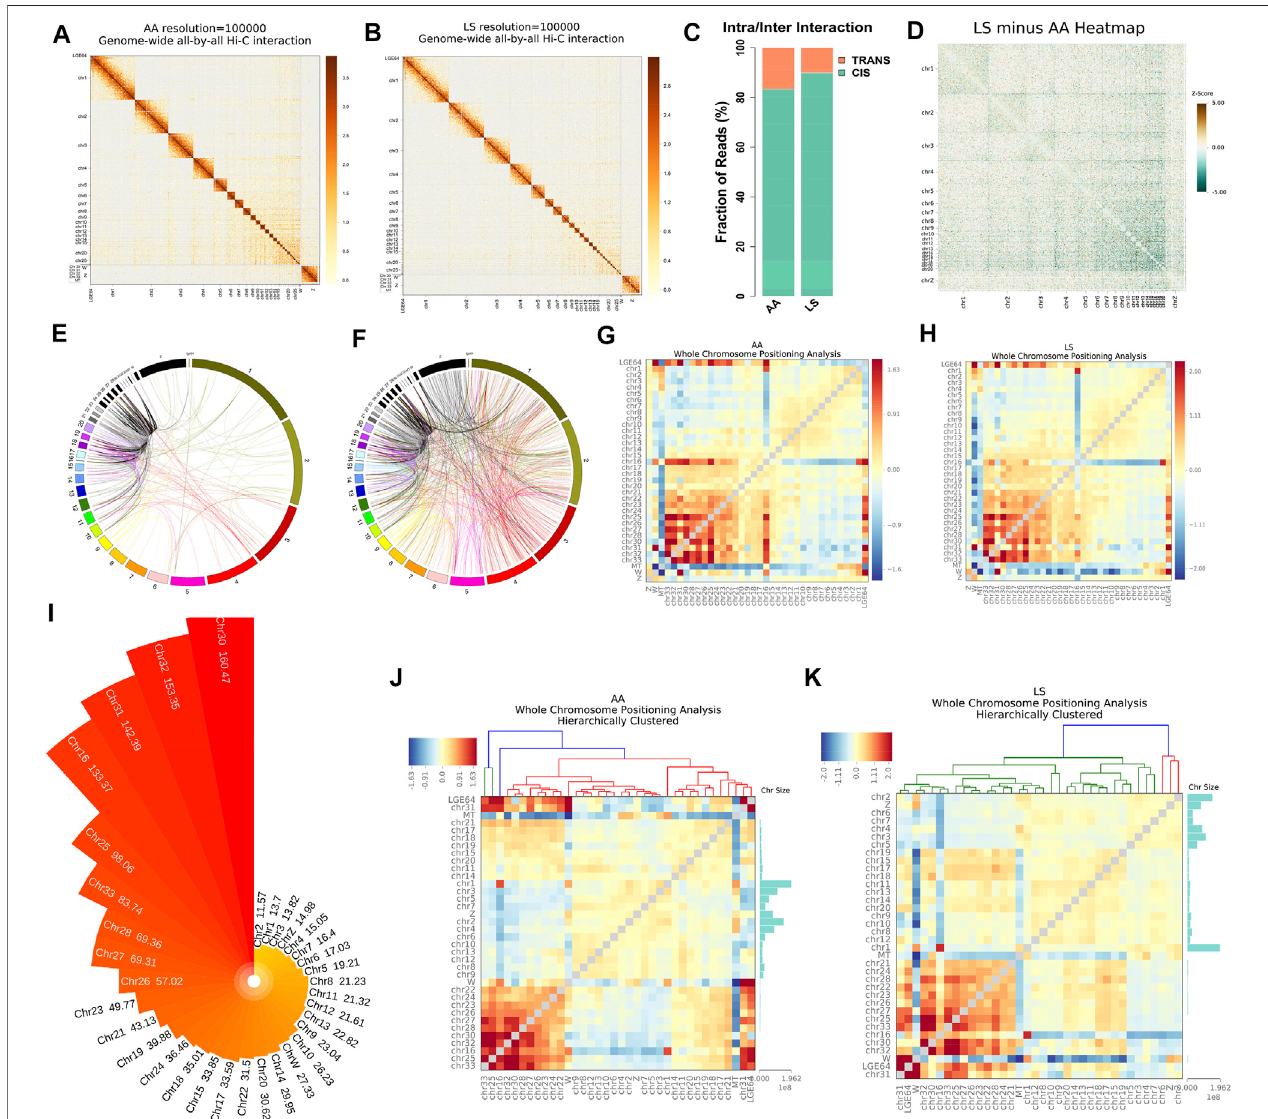
FIGURE 2 | Chromatin cis / trans interaction analysis of AA and LS chicken breast muscle using Hi-C. (A,B) Genome-wide all-by-all Hi-C interaction heatmap of breast muscles in AA broiler and LS chicken, respectively. (C) Genome-wide cis / trans interaction percentage of AA and LS chicken breast muscles. (D) Genome-wide heatmap of signi fi cant differential interactions between AA and LS chicken breast muscles. Chromosomes are stacked from top left to bottom right from chr1 through chr20andchrZ.TheredcolorrepresentsLS-enrichedinteractionsandthegreencolorrepresentsAA-enrichedinteractions,thewhiteregionsaretheinsigni fi cantly changed interacting regions between the two breeds. (E,F) Circle plot from 1,000 bin pairs with the strongest trans -interaction in AA and LS chicken breast muscles, respectively. (G,H) Standardized trans -interaction using observed/expected number of contacts between all pairs of whole chromosomes in AA and LS chicken breast muscles,respectively. (I) Genedensity ofeachchromosomeinchicken. (J,K) Hierarchicalclusteringanalysisofwholechromosomepositioningbetweenchromosomes of AA and LS chicken breast muscles, respectively.